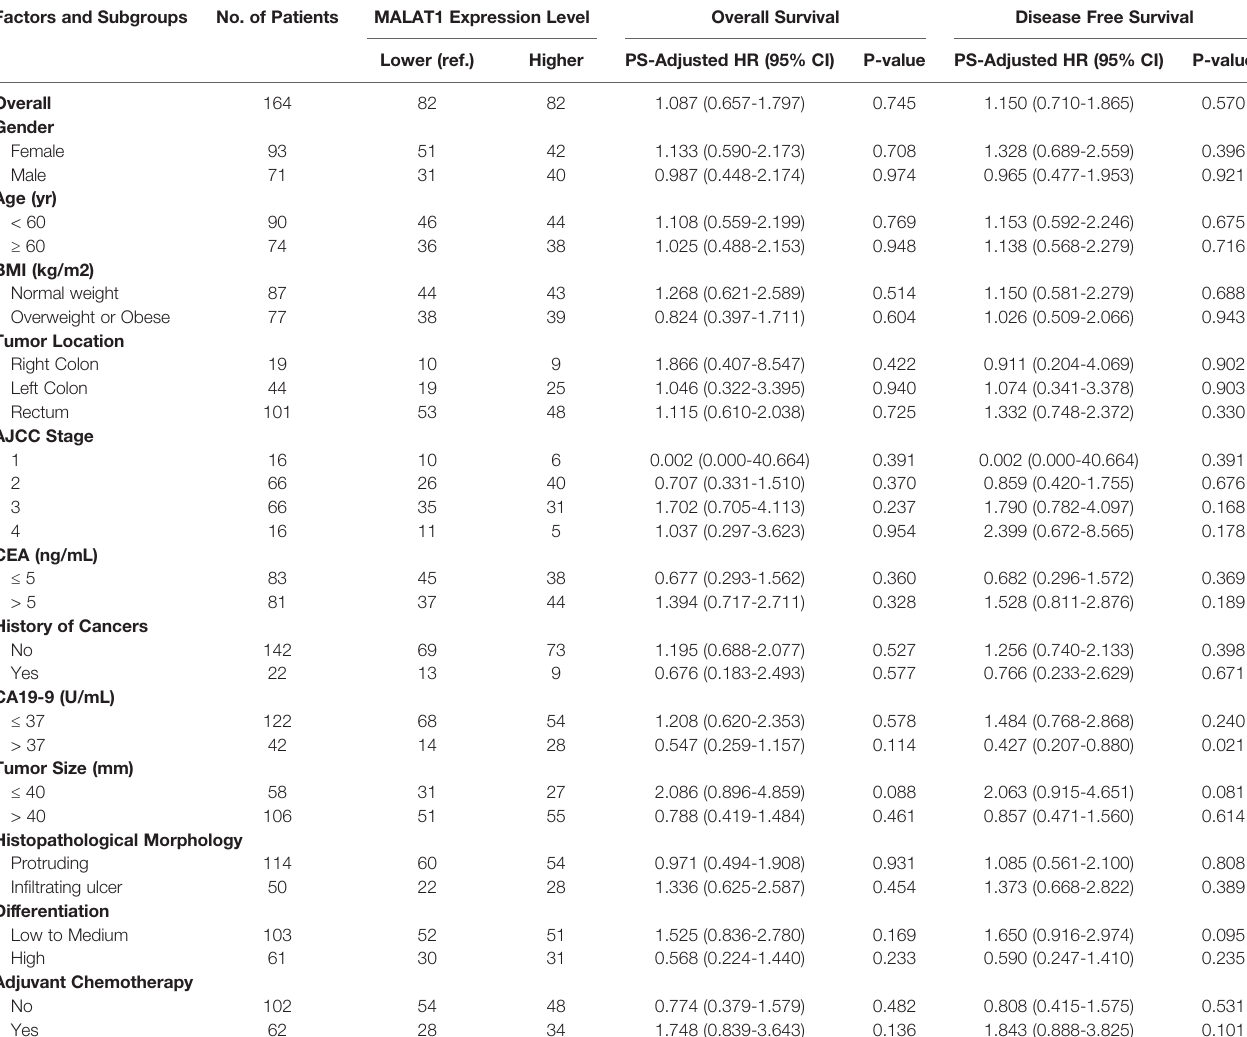
TABLE 1 | Prognostic associations of MALAT1 expression and colorectal cancer outcomes in the initial population. Factors and